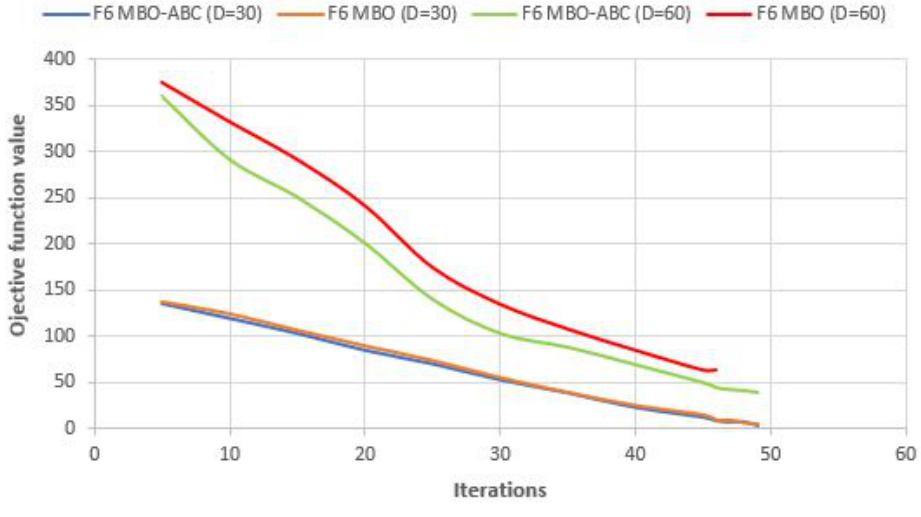
Figure 7. Convergence speed of MBO-ABC and MBO for F6 benchmark with D = 30 and D =